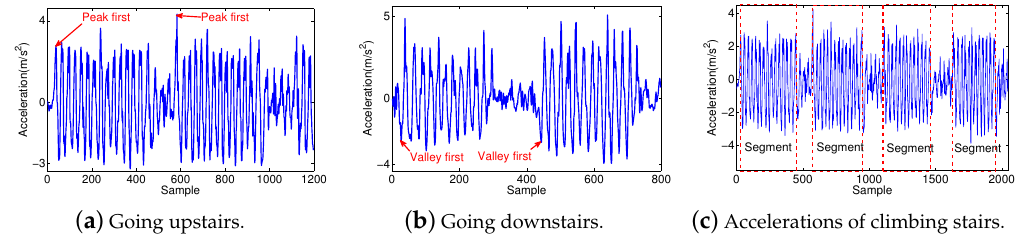
Figure 7. Accelerations of climbing stairs.